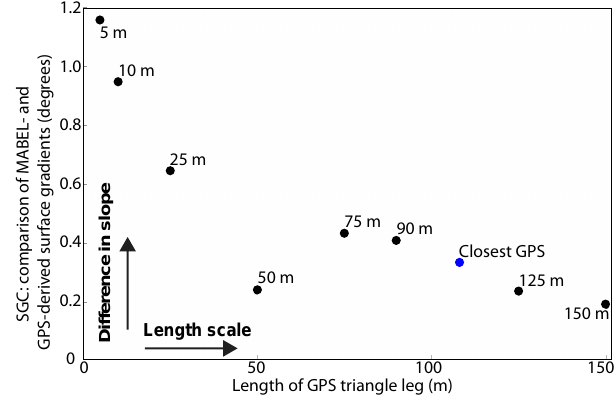
Figure 9. A surface-gradient comparison between a MABEL- derived surface (blue points in Fig. 3) and a series of GPS-derived surfaces, based on concentric equilateral triangles (black points here and in Fig. 3) and a surface based on the GPS survey sites that were closest to the nodes that defined the MABEL surface (blue point here and blue open circles in Fig. 3). The x axis is the length of each side of the equilateral triangles (or a mean length, for the “Closest GPS” surface); the y axis is the surface-gradient comparison (SGC) parameter (defined in Eq. 1), or the RSS of the difference in sur- face gradient ( δz/δx and δz/δy ), in degrees, between the MABEL- derived surface and each of the GPS-derived